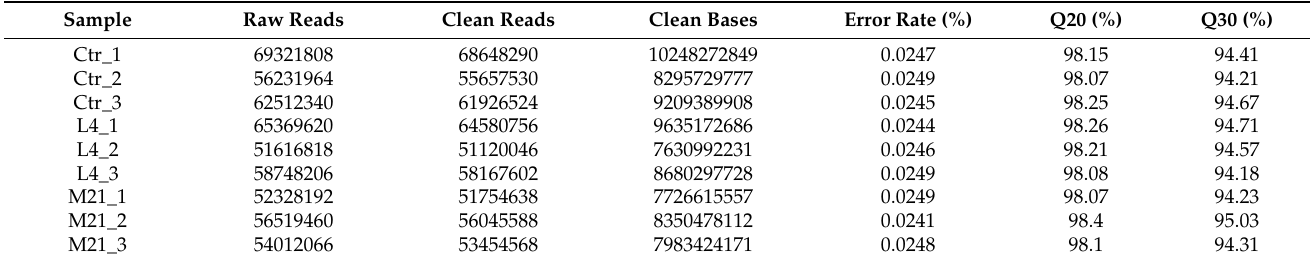
Table 2. Statistics and quality estimation of RNA-seq